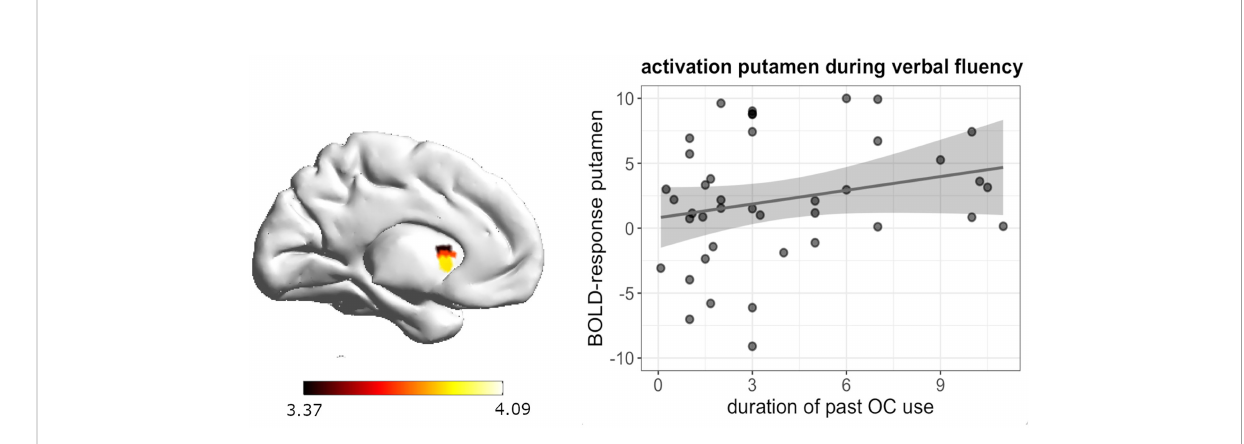
FIGURE 5 Positive association between duration of OC and left putamen activation during verbal fl uency in past OC users.